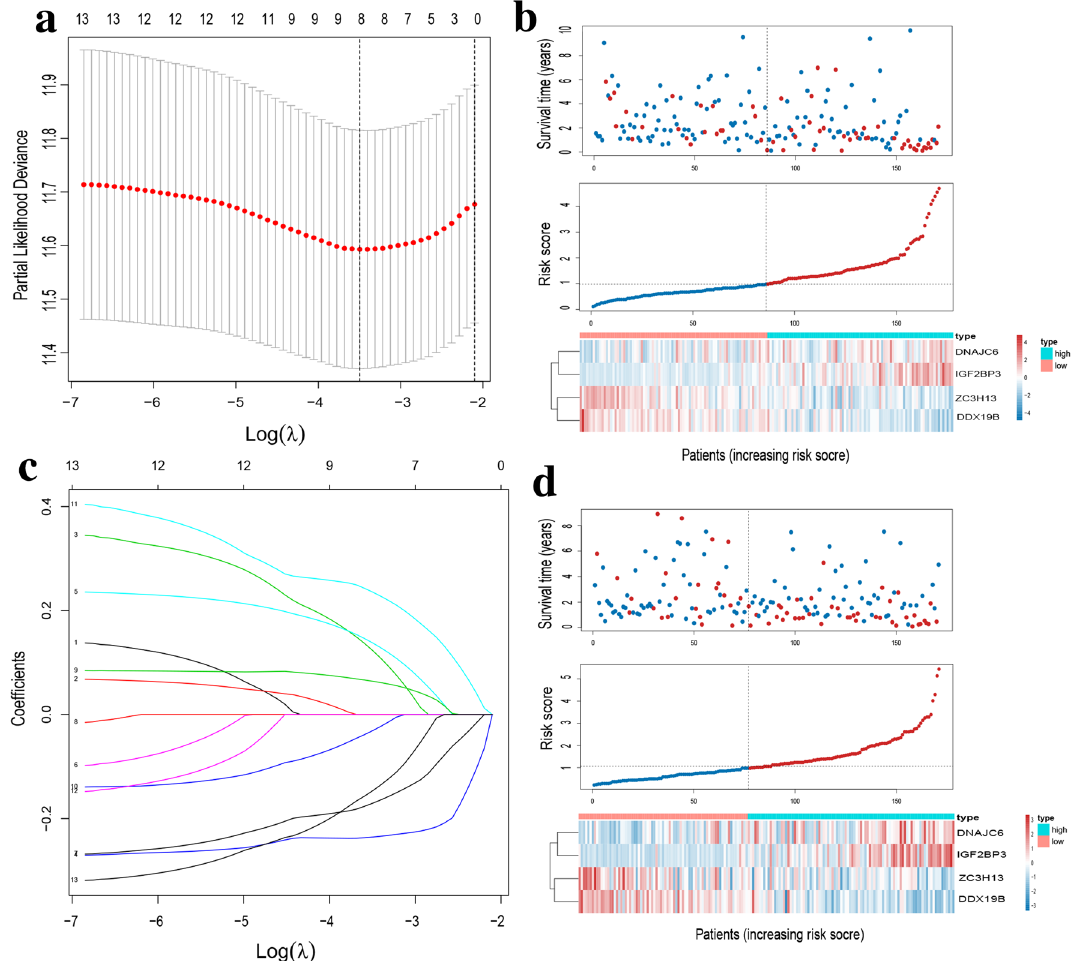
Figure 3. Construction of the prognostic risk score model based on SFs for HCC patients. ( a ) Selection of tuning parameter (λ) in the LASSO regression analysis via tenfold cross-validation. The dotted vertical lines were plotted at the optimal λ values based on the minimum criteria and 1 standard error of the minimum criteria. ( b ) LASSO coefficient profiles of the 13 survival-associated SFs. The dotted vertical line was plotted at the same position as the dotted vertical line in ( a ), producing 8 nonzero coefficients (THOC5, SRSF5, DNAJC6, ZC3H13, IGF2BP3, C9orf78, SF3B4, and DDX19B). ( c ) Risk plot of HCC patients in the training set; ( d ) risk plot of HCC patients in the validating set. For ( d,e ), Upper part assembly indicated the distribution of HCC patients’ survival status and survival times ranked by risk score; the middle part represented the increasing risk score curve, in which HCC patients were divided into low-risk (blue) and high-risk (red) subgroup according to the median value of risk scores of patients in the training set; and the bottom heatmap displayed expression pattern of SFs involved in the prognostic